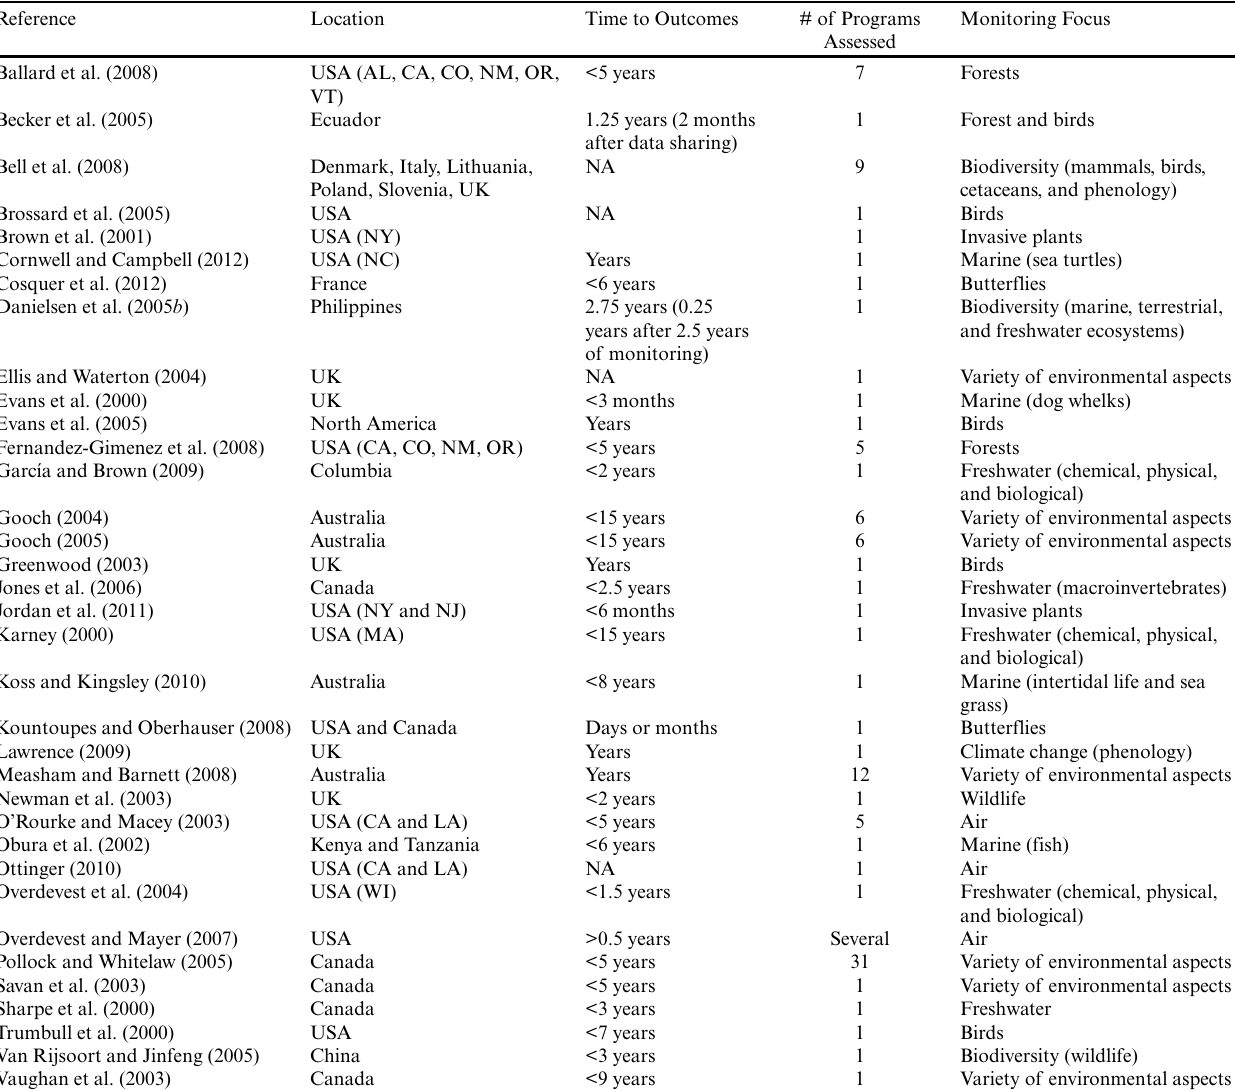
Table 2 . Characteristics of volunteer environmental monitoring efforts for which participant or community outcomes were reported in peer-reviewed journal